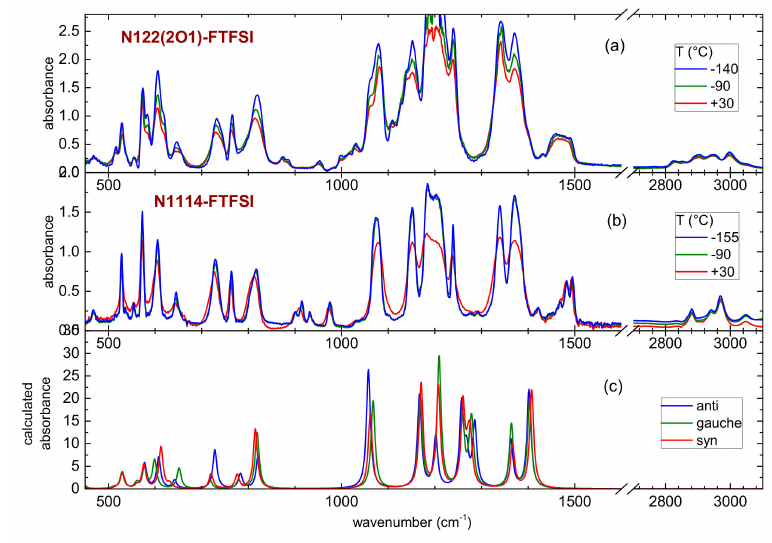
Figure 6. Temperature dependence of the mid-infrared spectrum of N122(2O1)-FTFSI (panel ( a )) and N1114-FTFSI (panel ( b )) and comparison with the calculated absorbance of the three conformers of the FTFSI anion (panel ( c )); a scaling factor of 1.04 was used for the calculated frequencies.